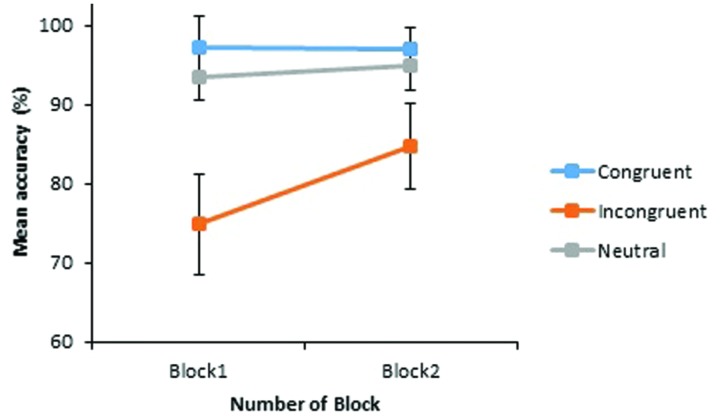
Experiment 1: mean percentages of correct judgments to critical word pairs in Block 1 and Block 2. The vertical axis begins at 60% while error bars indicate the 95% confidence intervals.